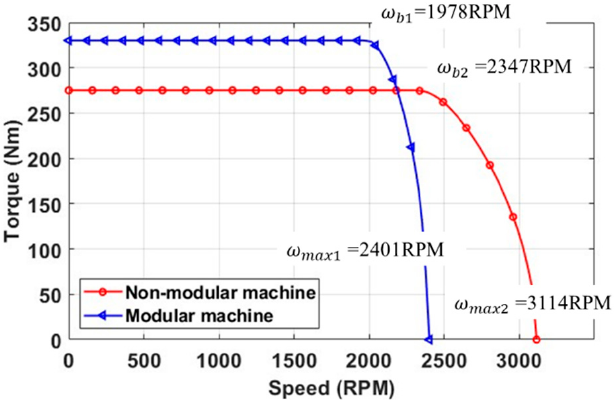
Figure 3. Torque-speed curves for the modular and non-modular machines at room temperature (20 °C) without considering EM–thermal coupling.